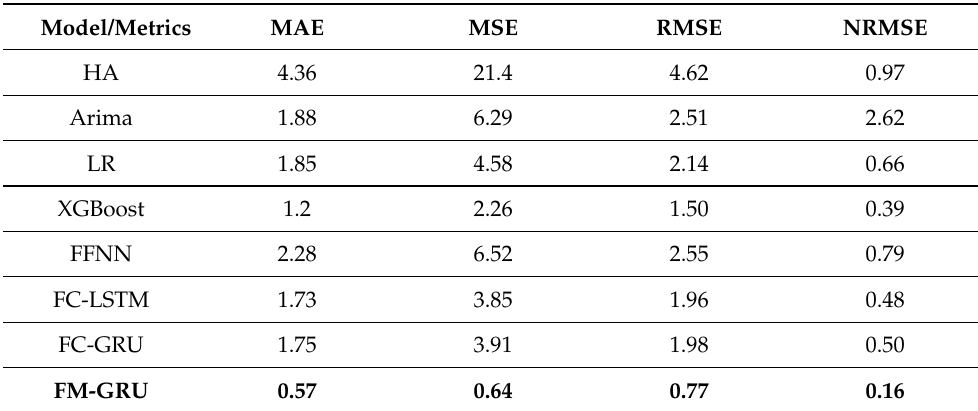
Comparison of the performance of different methods in predicting the value of dissolved oxygen.